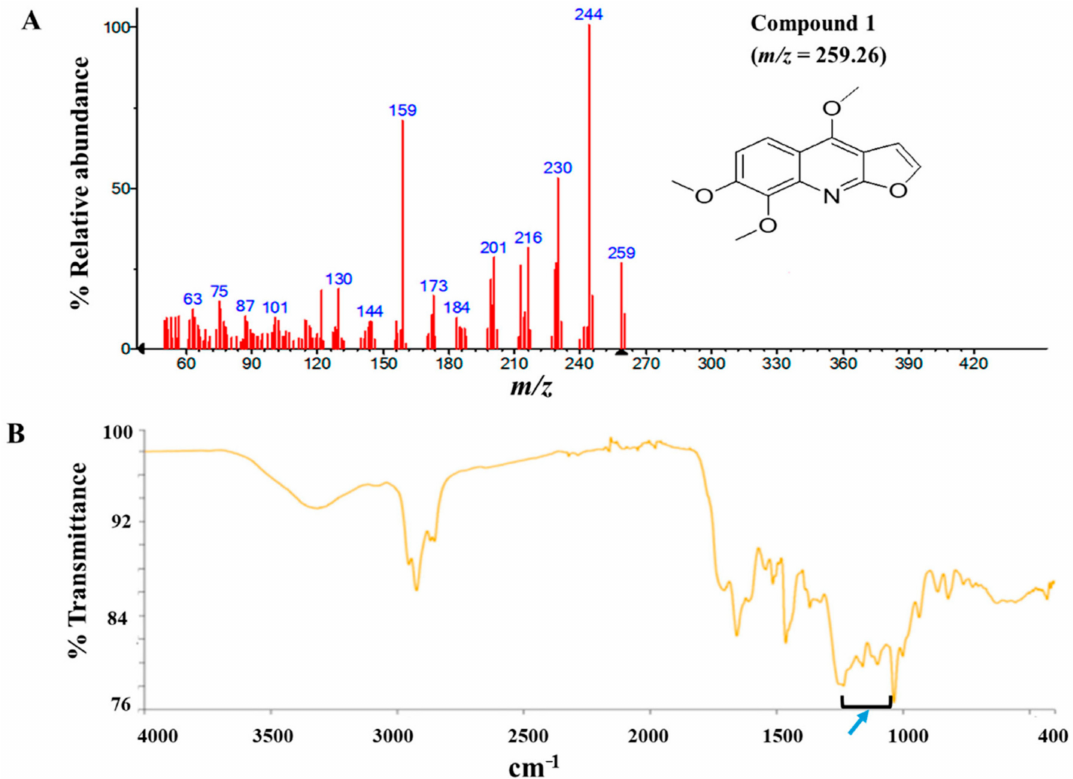
Figure 2. GC-MS and Attenuated Total Reflectance (ATR)-IR analysis of compound 1 : Compound 1 was isolated from the dichloromethane fraction of Z. zanthoxyloides (root) and identified through gas chromatography-mass spectrometric (GC-MS) analysis. The mass fragmentation of compound 1 identified it as 4,7,8-trimethoxyfuro (2,3-b) quinoline with m / z = 259.26 ( A ). The aromatic nature of compound 1 was suggested by the absorbance at 1335–1250 cm − 1 (( B ), blue arrow). Eleven gravity column chromatographic fractions of the dichloromethane fraction of Z.